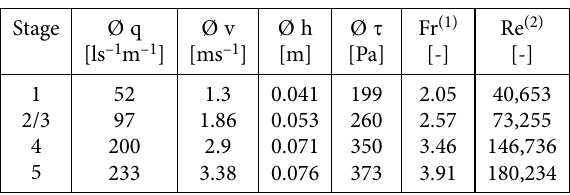
Table 2. Mean unit discharges (q), measured and computed Table 5. Max. cumulative soil loss (CSL) and hydraulic forces, hydraulic values (flow velocity (v), discharge depth (h), shear short-term tests series, unvegetated, September 2014 stress ( τ )), Froude & Reynolds numbers, vegetated, September 2014